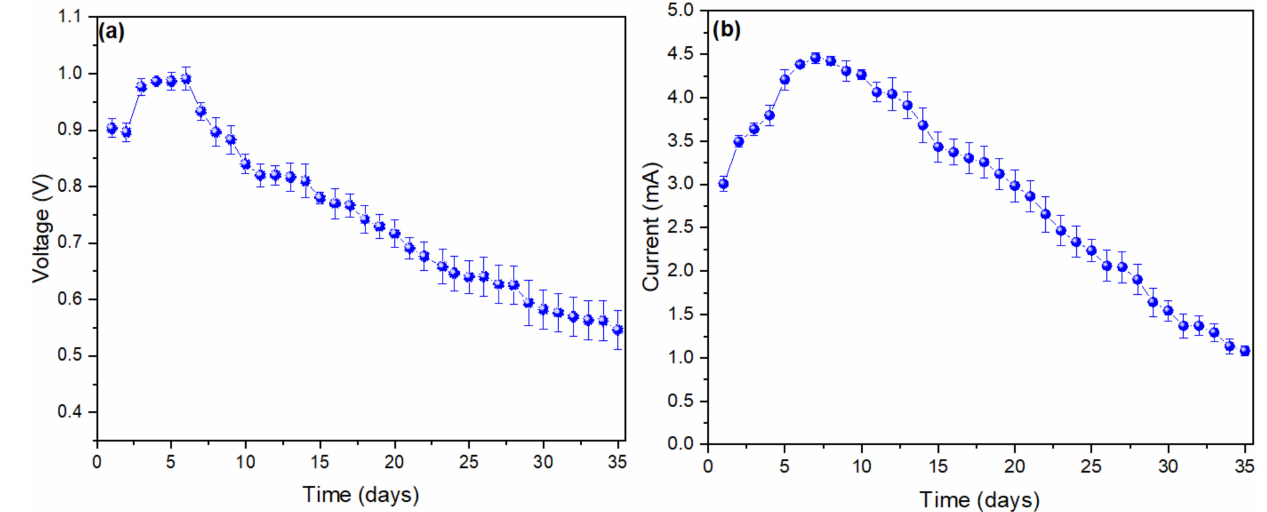
Figure 2. Monitoring of the values of ( a ) voltage and ( b ) current of the microbial fuel